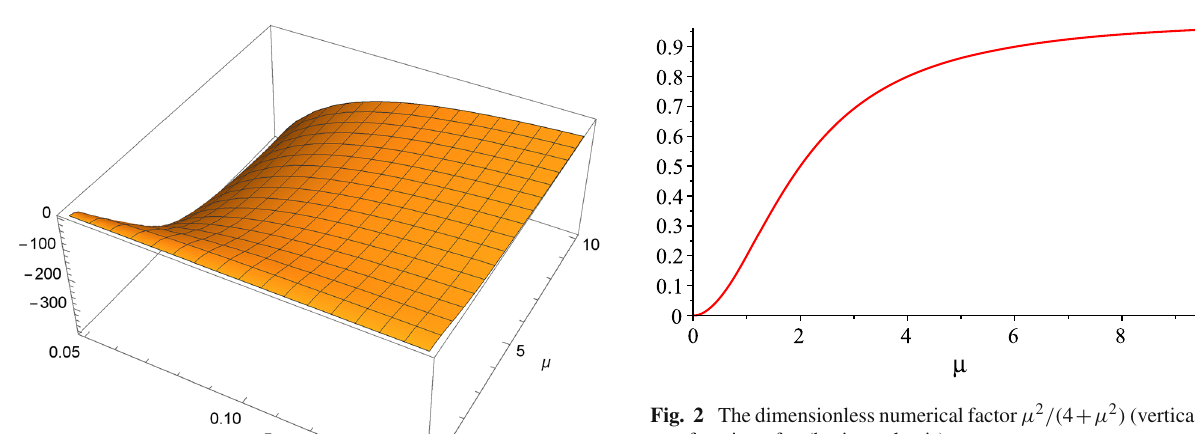
Fig. 1 Force (24) multiplied by 16 π